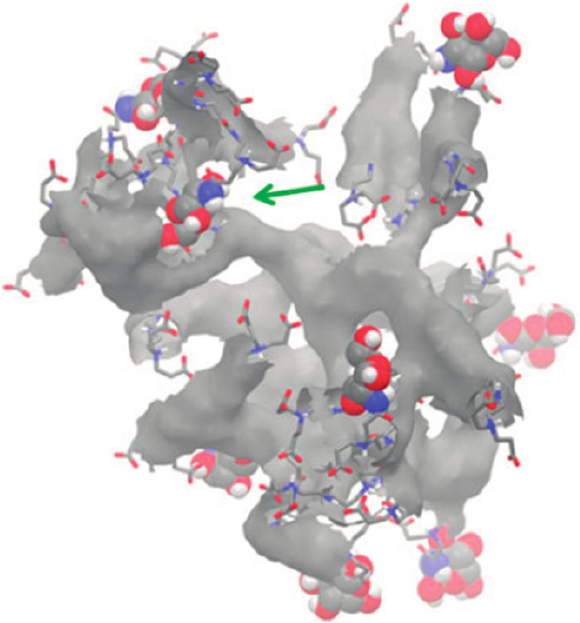
Figure 7. Availability of the substituted terminal glucosamine groups on PAMAMs’ surface. Reprinted from